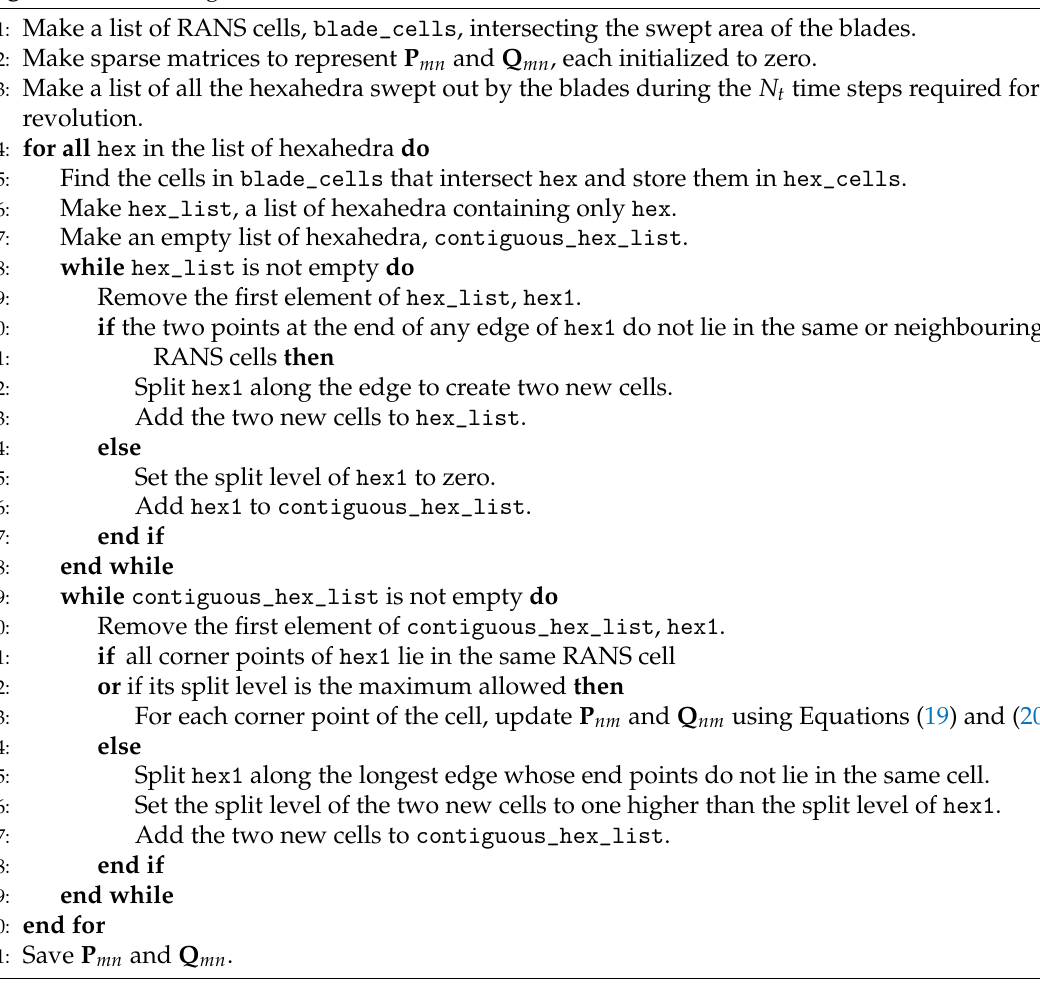
Algorithm 1 Basic algorithm to calculate P nm and Q nm